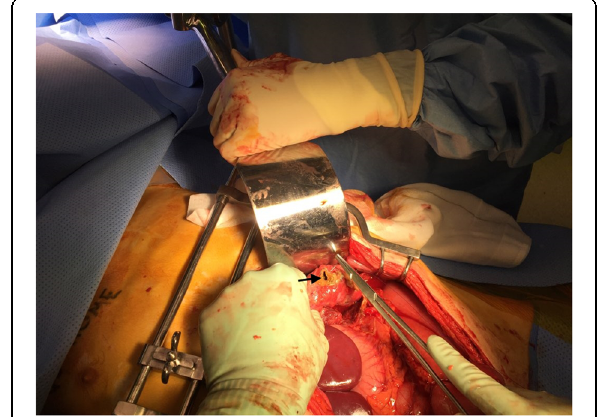
Fig. 2 Intraoperative view of the inferior aspect of the left diaphragm. Black arrow points to the diaphragmatic hernial defect